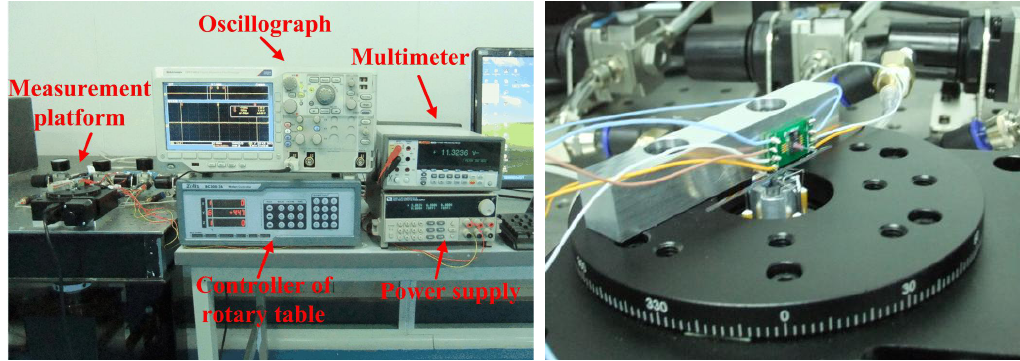
Figure 15. Photo of the assembled system ( left ) and the measurement platform ( right